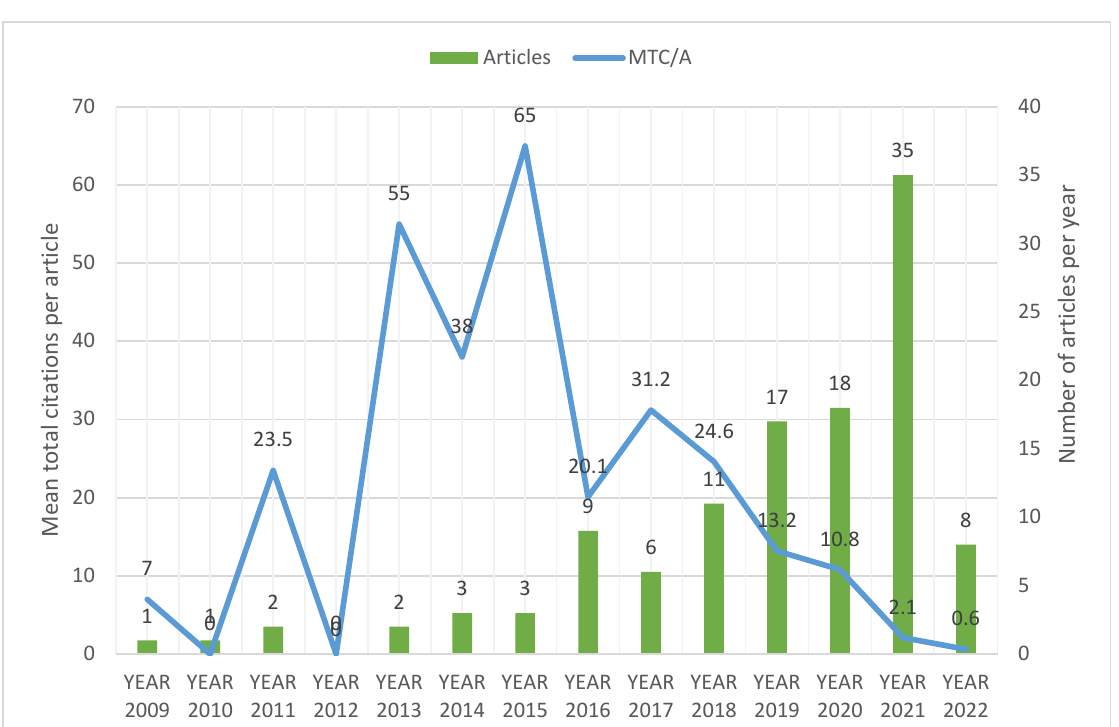
Figure 2. Yearly scientific production of CSA-CCAP publications indexed in Scopus from 2009 to March 2022. MTC/Y = mean total citations of published paper per year. NB: the annual percentage rate of increase was 19.